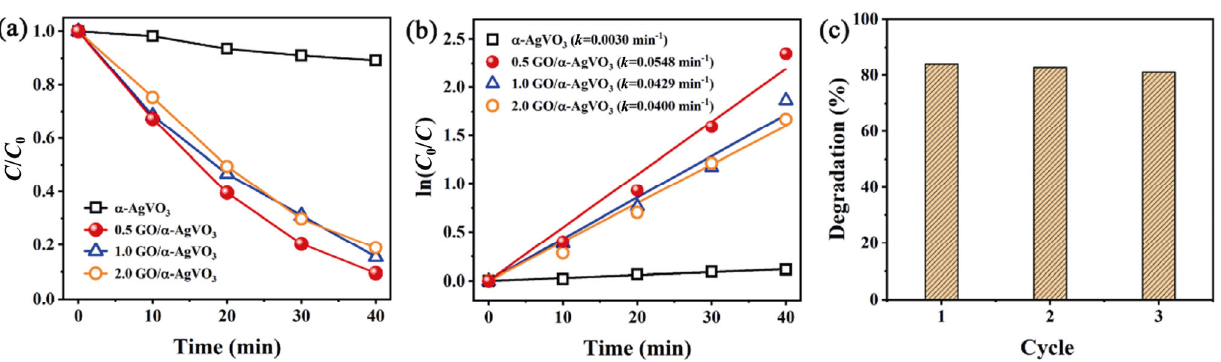
Fig. 7 (a) Photocatalytic degradation curves of RhB, (b) corresponding pseudo-first-order kinetic curves, and (c) cyclic tests of the 0.5 GO/ α -AgVO 3 .